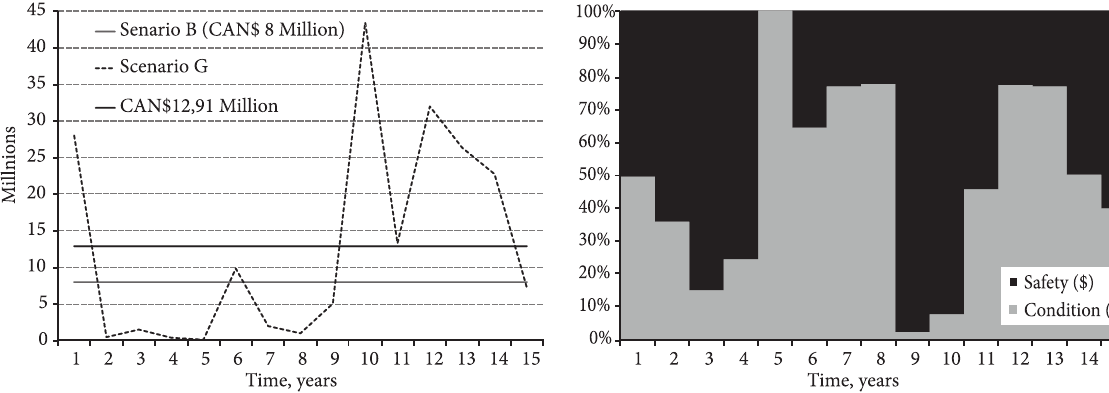
fig. 2. Mean annual expenditure and budget allocation for Scenario table 3. Dominance and performance criteria for a fixed budget of 5 mln EUR Scenario